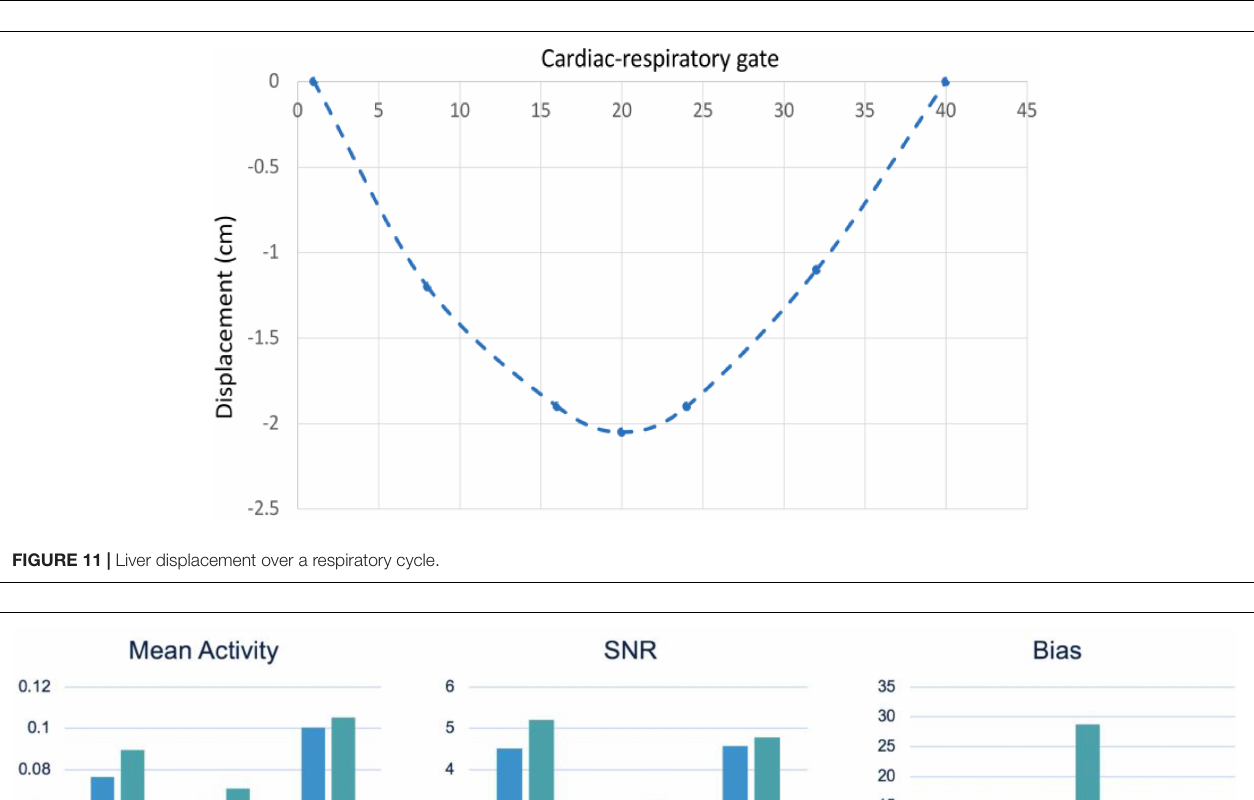
FIGURE 10 | Coronal views of heart in an exhalation-inhalation sequence during one respiratory cycle. The respiratory period was 5 s while the heart beating period was 1 s. The cross hair marks the center of the left ventricle and the first frame represents the end-exhalation. The vertical shift of the myocardium is represented by an arrow.